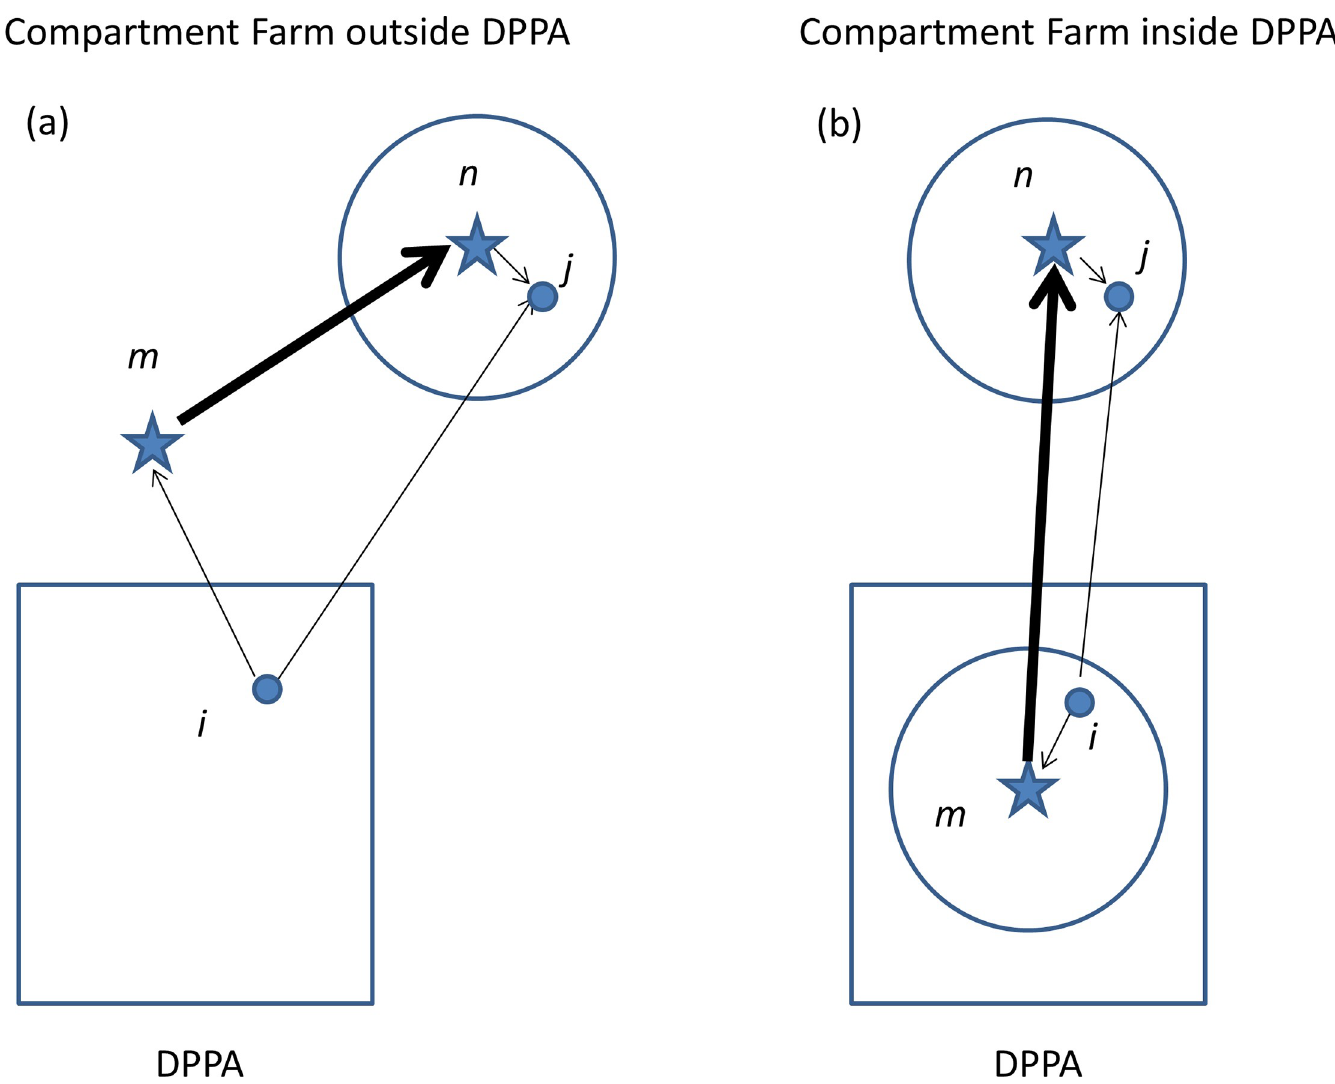
Fig 1. ‘Single-event’ transmission from source farm i to receiver farm j, both located outside the compartment (i.e. represented by a dot), compared to ‘triple- event ‘ transmission from source farm i to receiver farm j via farms m and n, both located inside the compartment (i.e. represented by a star). Thick lines represent HPAI transmission by the combination of neighbourhood transmission and by between-herd contact events. Thin lines represent HPAI transmission by neighbourhood transmission only. Circles represent the 10 km surveillance zone around the compartment farms m and n. DPPA means Densely Populated Poultry livestock Area. Shown are the possibilities that the compartment farms (m and n) are situated outside the DPPA (Fig 1A) and that one compartment farm (farm m) is located within the DPPA (Fig